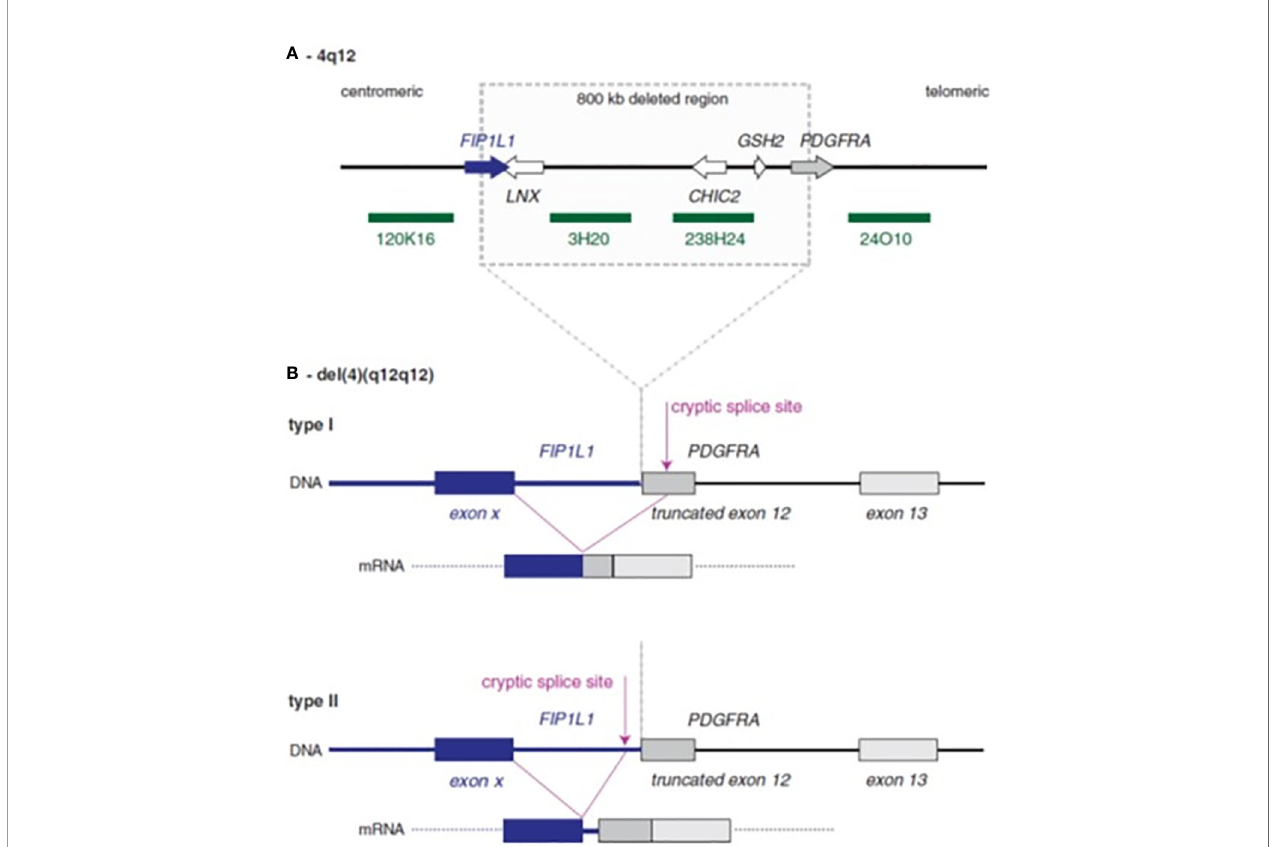
FIGURE 1 | Schematic representation of FIP1L1 – PDGFRA rearrangement. (A) Normal 4q12 region with sites of deletion in cases with the FIP1L1 – PDGFRA fusion. The four green bars denote probes that can be used to detect the deletion by fl uorescence in situ hybridization. (B) The consequences of deletion: FIP1L1 usually breaks within an intron, while PDGFRA always breaks within exon 12. To obtain splicing between FIP1L1 and PDGFRA , cryptic splice sites need to be used, because the normal splice site in the exon 12 is removed by the deletion. This cryptic splice site could be located either within exon 12 of PDGFRA (type I fusion) or within the intron of FIP1L1 (type 2